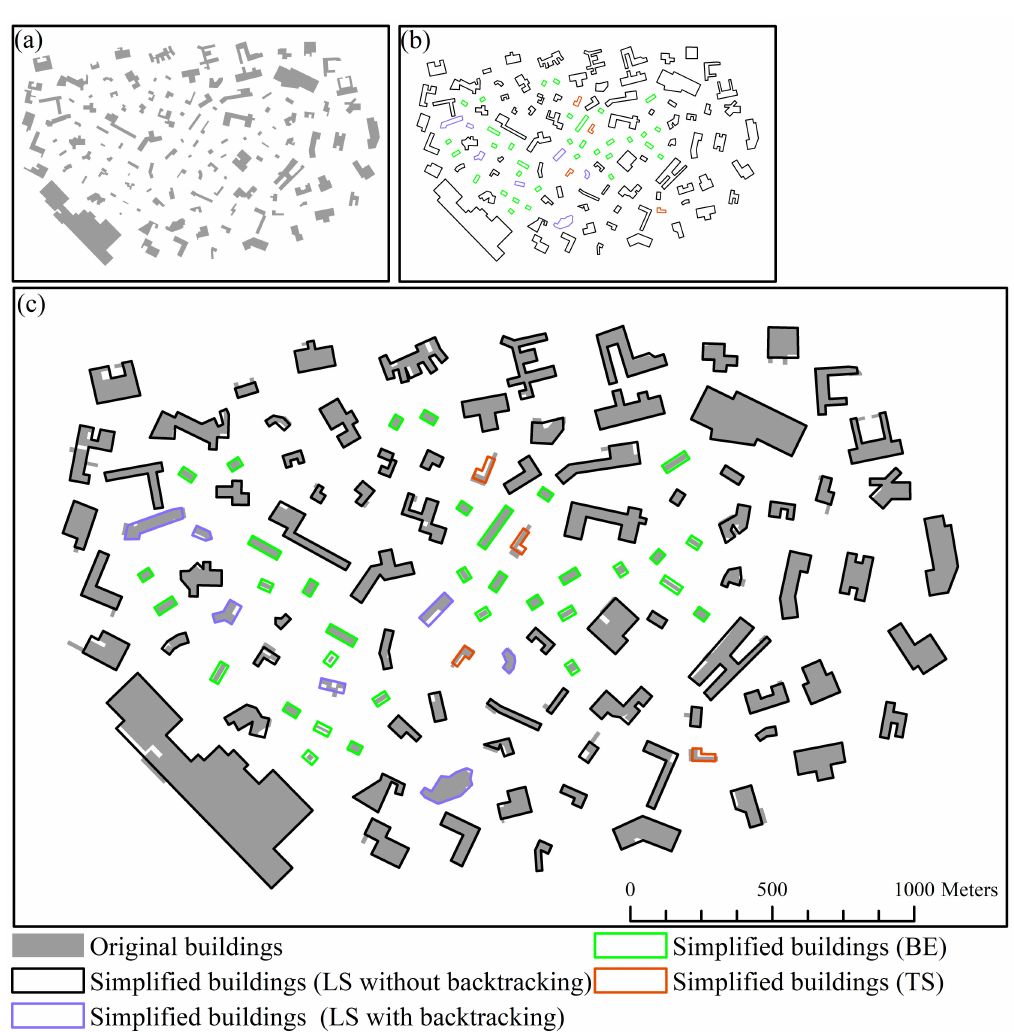
Figure 8. Simplified buildings at scale 1:25k: ( a ) original dataset; ( b ) simplified result; ( c ) comparison between the two. Result is scaled up for a clear